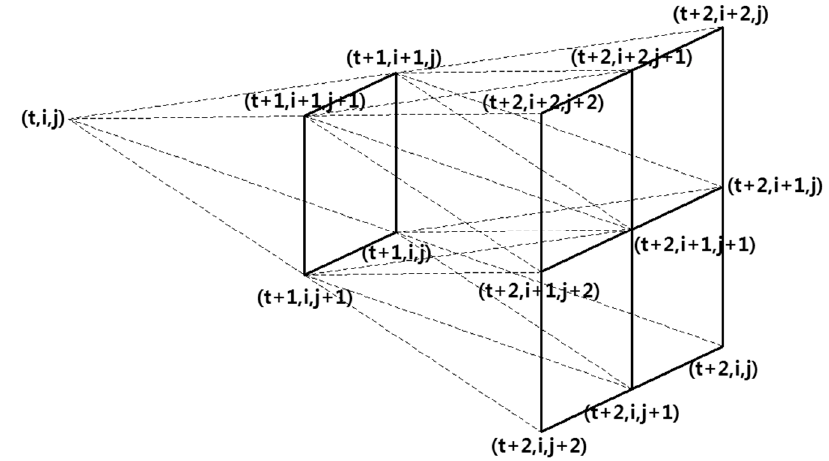
Figure 2. Three-dimensional binomial lattice.